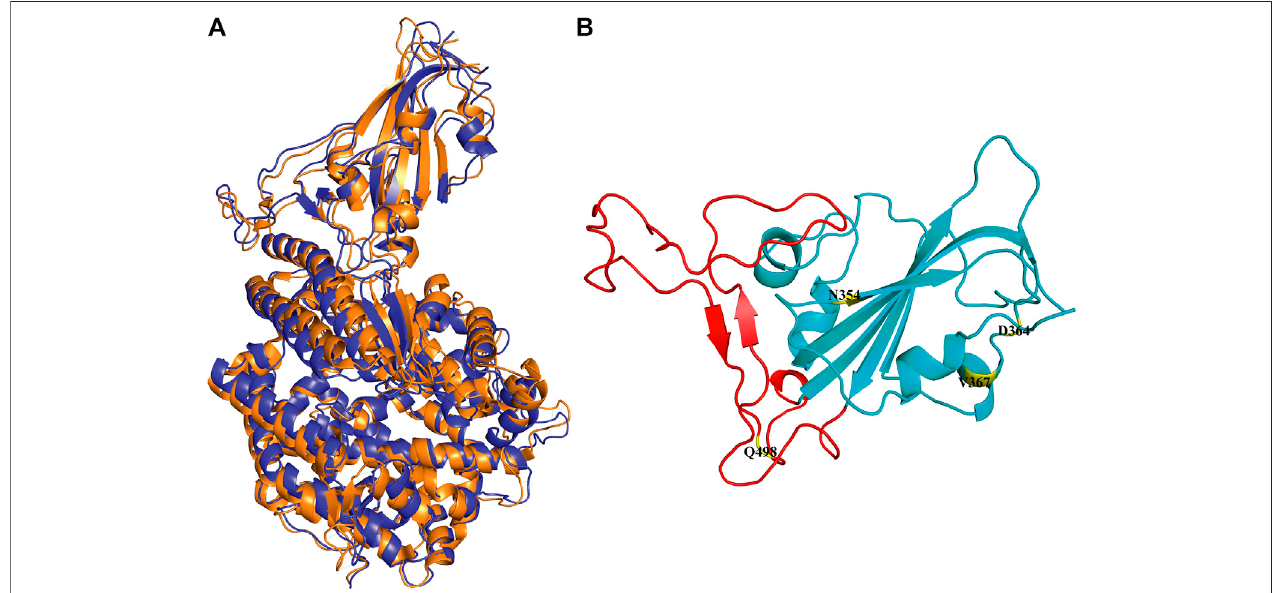
FIGURE 1 | Conformation of WT RBD/hACE2 and position of four mutations in the RBD domain. (A) The crystal is illustrated in orange, and the representative structure after simulation is in blue. (B) The four mutation sites are shown in yellow, and the range of red fragments represents RBM.